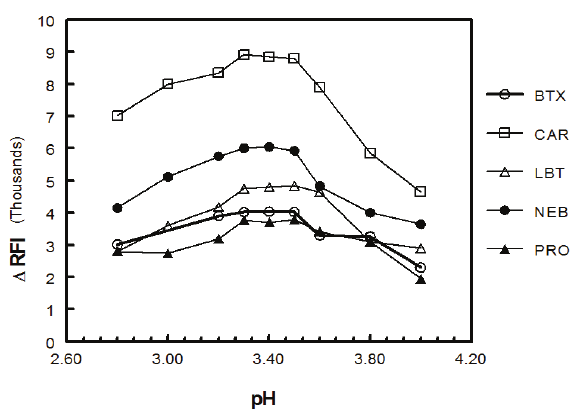
Figure 2: Effect of pH on the reaction of the studied drugs (2 µg mL -1 ) of BTX (○), CAR (-□-), LBT (-∆-), NEB (-●-) and PRO (- ▲ -) with eosin Y.